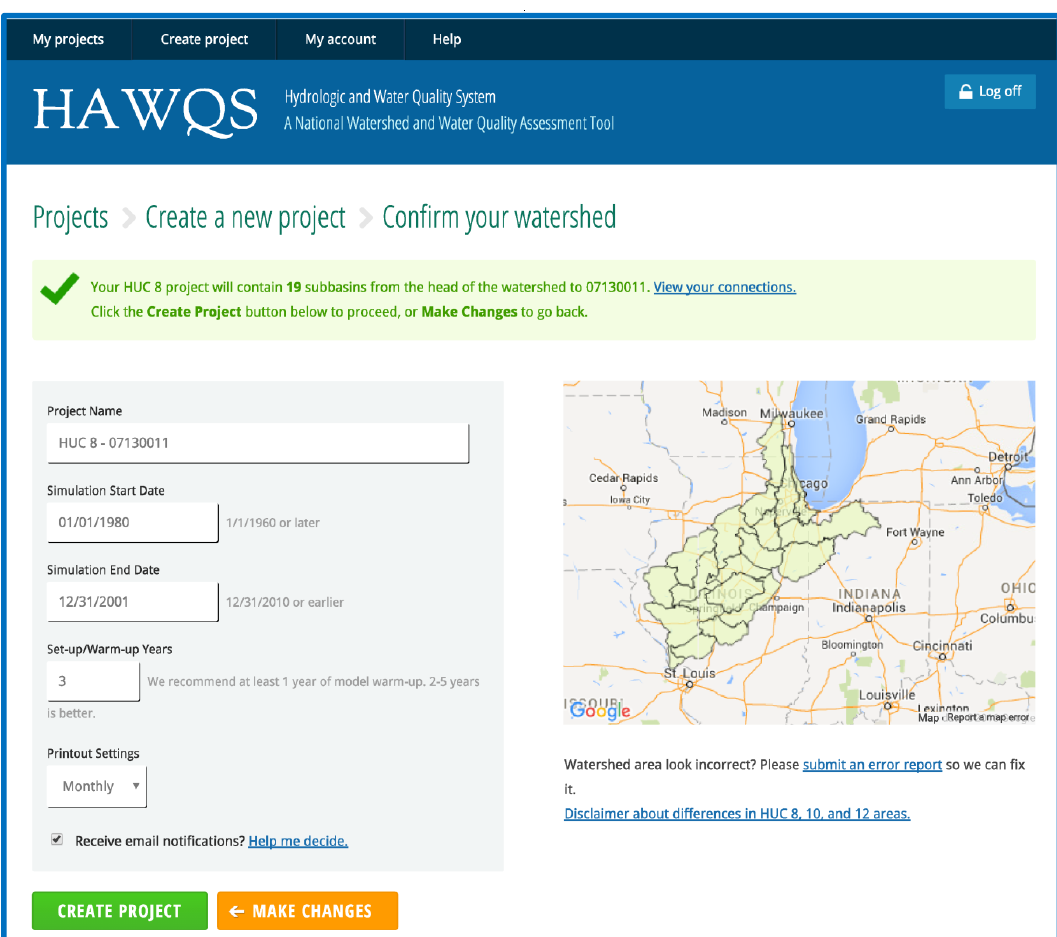
Figure 3. Initialization—watershed confirmation.